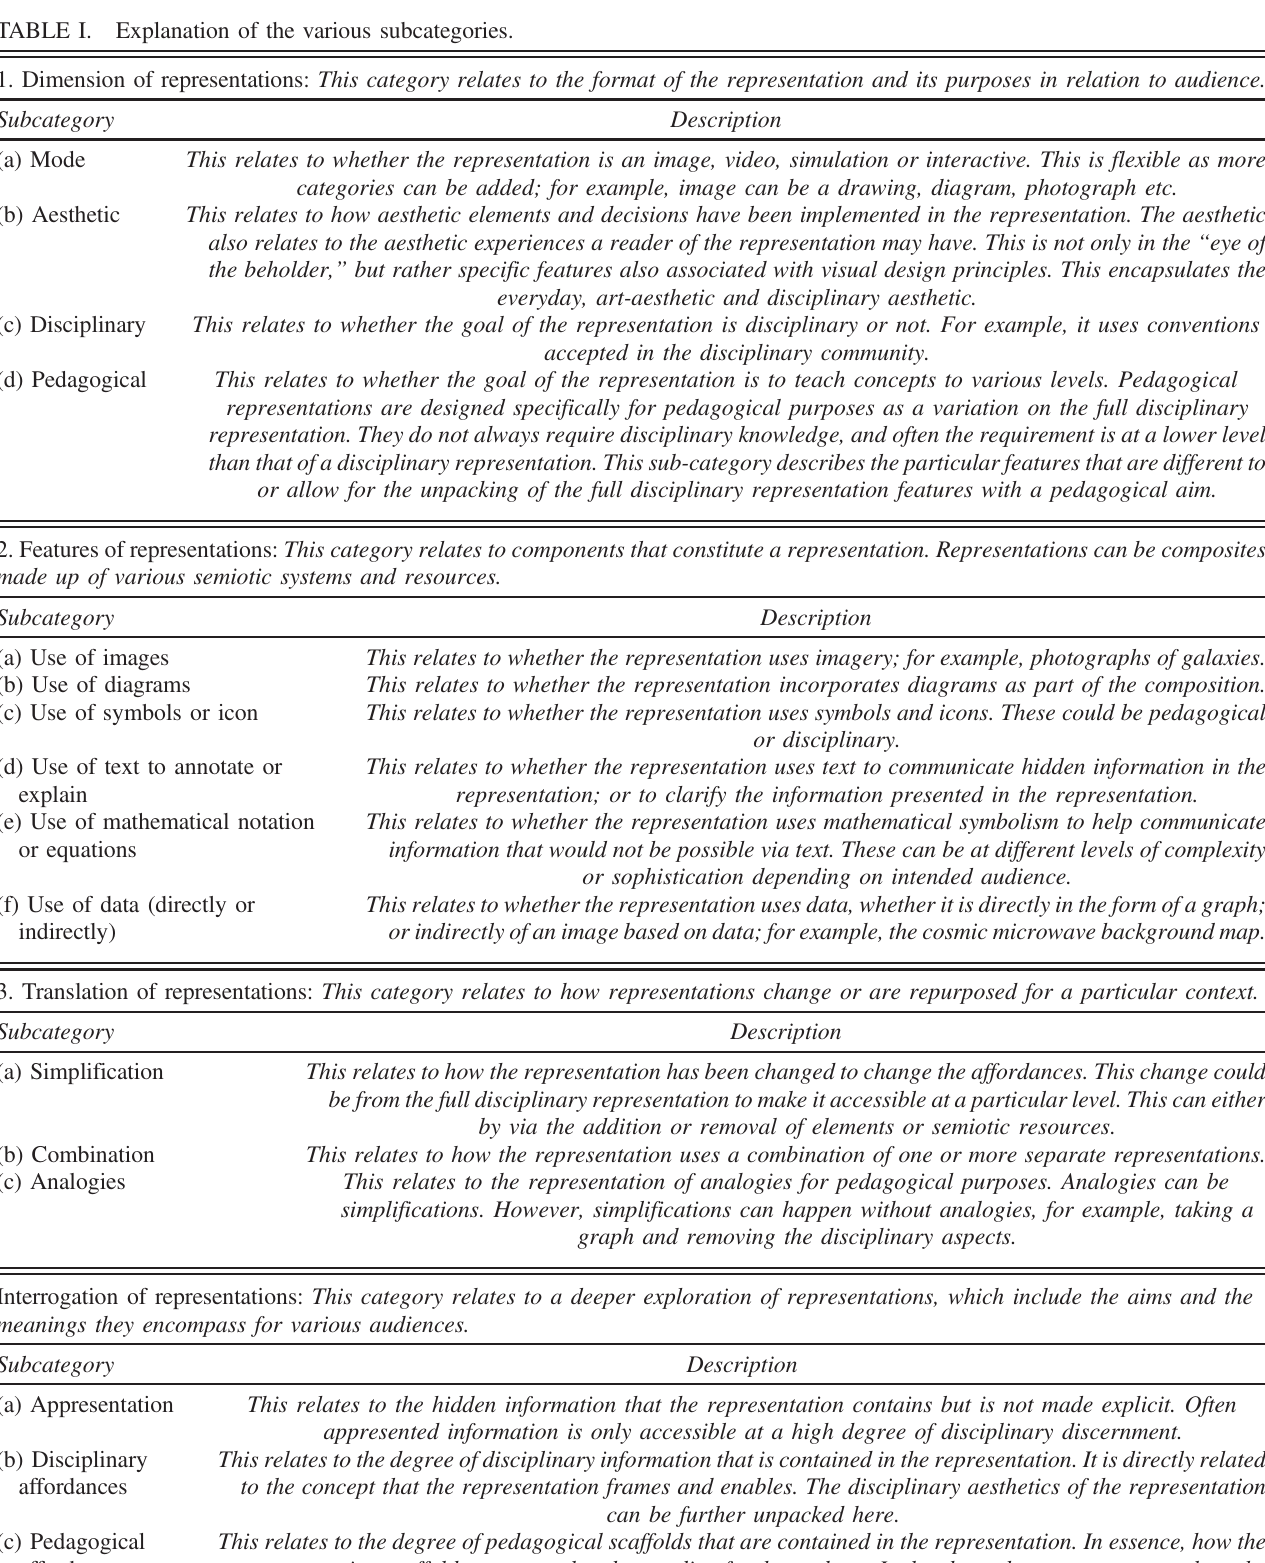
TABLE I. Explanation of the various